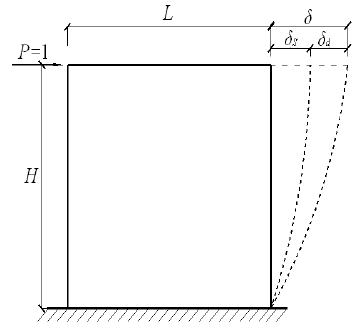
Figure 17. Calculation model of initial stiffness.